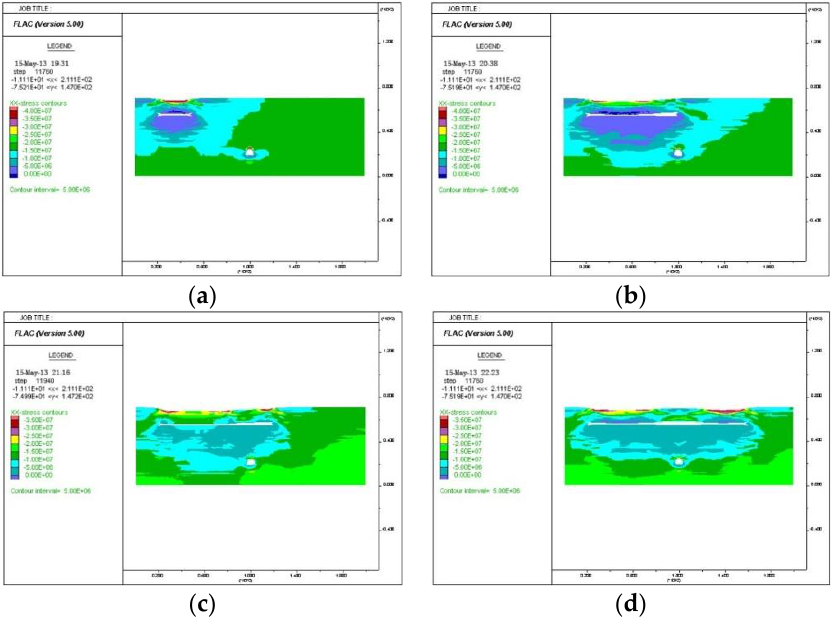
Figure 17. Horizontal stress distribution of surrounding rock of roadway supported by anchor– shotcreting–grouting support. ( a ) Working face is 60 m away from the roadway. ( b ) Working face is 0 m away from the roadway. ( c ) Working face spans the roadway 20 m. ( d ) Working face spans the roadway 60 m.